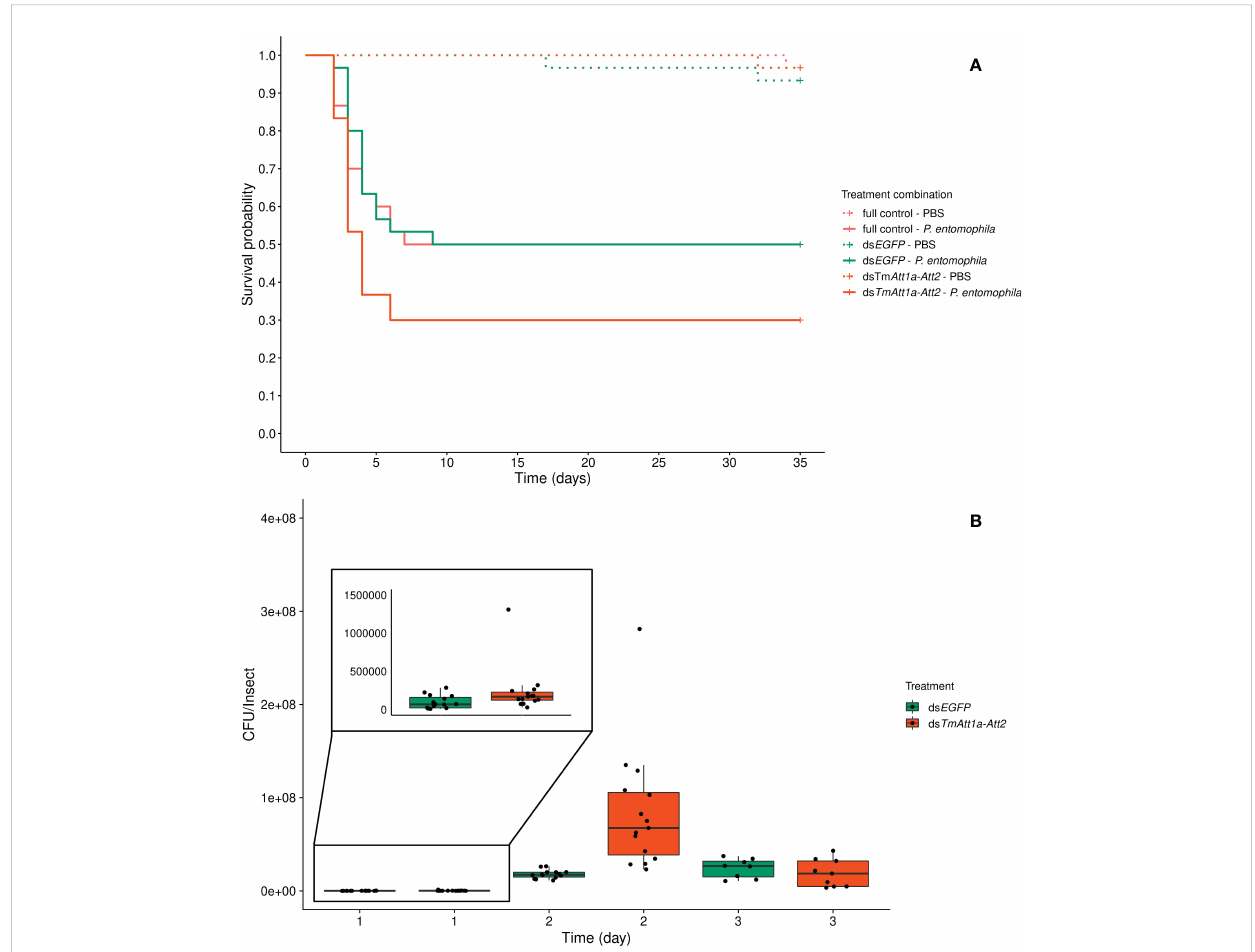
FIGURE 4 (A) Effect of TmAttacin1a-2 ( TmAtt1a-Att2 ) double-knockdown on survival of Pseudomonas entomophila infected Tenebrio molitor females over 35 days. ds EGFP was injected as a negative control for the nonspeci fi c effects of dsRNA and the third group includes dsRNA untreated control. Two independent experiments each performed on 15 females per treatment group. Each dsRNA-treated or dsRNA-untreated groups were infected with P. entomophila on day 4 after dsRNA treatment based on the data on knockdown ef fi ciency (Figure S10). Pink dashed line: Full control-PBS; Turquoise dashed line: ds EGFP - PBS; Orange dashed line: ds TmAtt1a-Att2 - PBS; Pink line: Full control - P . entomophila ; Turquoise line: ds EGFP - P . entomophila ; Orange line: ds TmAtt1a-Att2 - P . entomophila . (B) Bacterial load in ds TmAtt1a-Att2 -silenced T. molitor challenged with P. entomophila at 1-, 2-, and 3-day post-infection. The colony-forming units (CFU) recovered from tissues of T. molitor females from ds TmAtt1a-Att2 (orange) and ds EGFP (control, turquoise). In the box plots, the lower ( fi rst) quartile is the closest boundary to zero, the line within the box marks the median (second quartile), and the upper (third) quartile. Each dot represents the CFU count in an individual beetle. The bars represent the